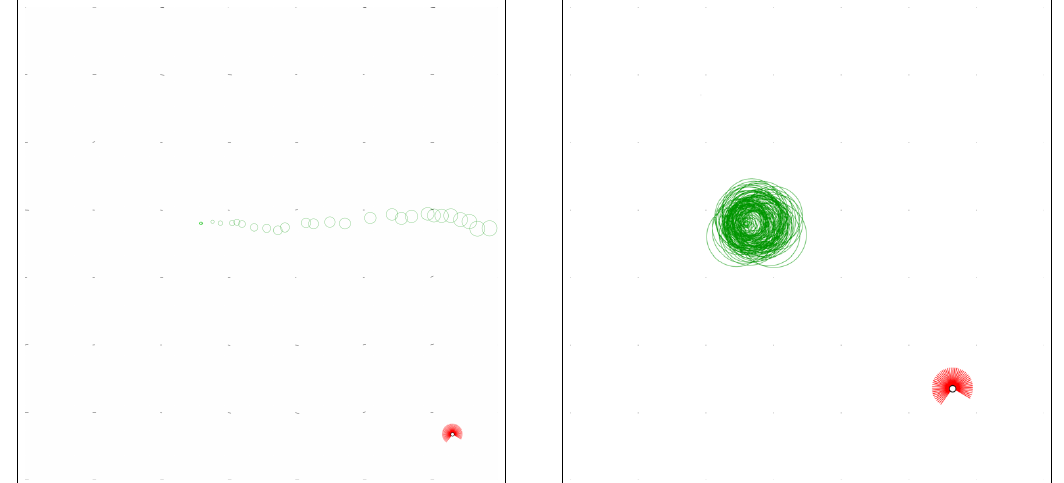
Figure 3. Screenshots of the developed simulator showing the advection-dominated ( left ) and diffusion-dominated ( right ) environments used in this work. Each environment is an enclosed rectangular space, containing a single odour source (thick green circle). In the advection-dominated environment, the wind flows from the left to the right of the environment, carrying the odour filaments (thin green circles). Conversely, in the diffusion-dominated environment, the weak and unstable air flow is unable to carry the odour filaments away from the source, clustering in its vicinity. The molecular dispersion of odour is represented by the increase of the diameter of the filaments. The wind velocity is computed on a grid which covers the entire arena. The wind vector of each vertex of the grid is shown as a black line, indicating its direction and speed. Each screenshot contains one mobile robots (black circle), equipped with the necessary sensors to perform odour source localisation. The red lines drawn over the robot represent the beams from its simulated Laser Range Finder, used for obstacle